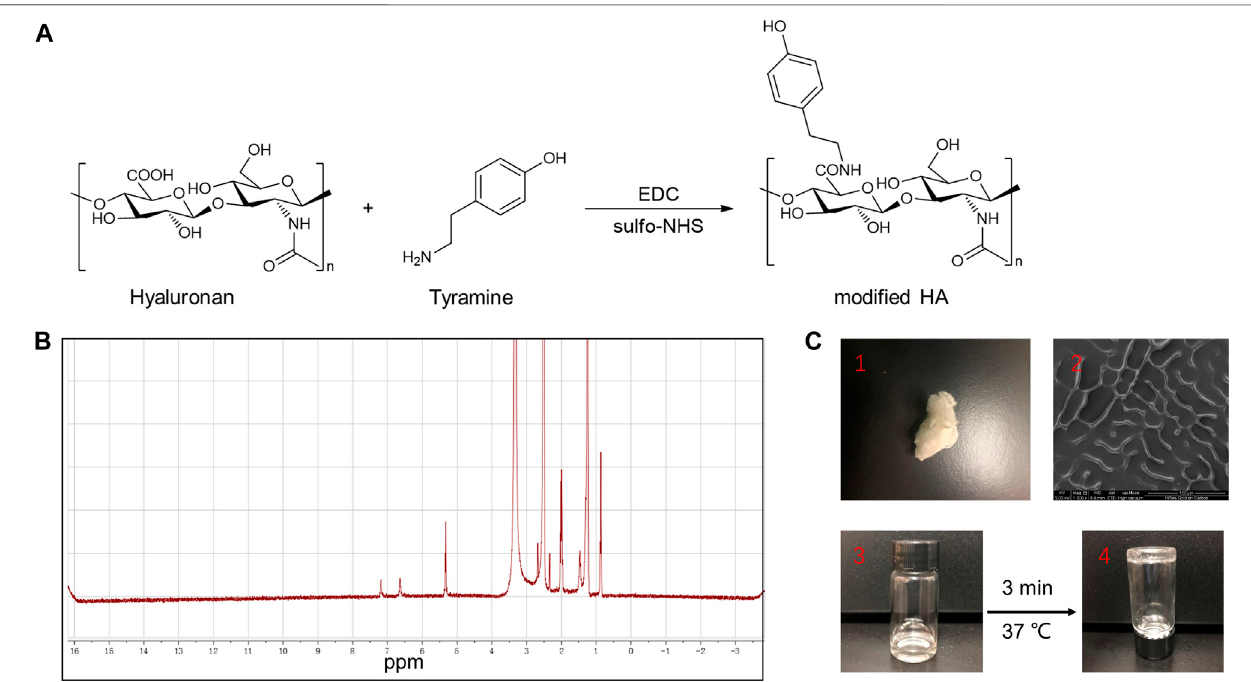
FIGURE3|(A) Synthesis ofTA-HA. (B) 1HNMRspectra ofmodi fi ed HA.( C -1) Themorphologyofthefreeze-dried TA-HA, waswhite fl occulent.( C -2) SEMimage ofTA-HA.( C -3)Themorphologyoffreeze-driedTA-HAinPBSsolutionwastransparent,colorless,and fl uid.( C -4)UnderthecatalysisofHRPandH2O2,TA-HAformed hydrogels after 3 minutes, and the morphology of hydrogels had a transparent and non- fl uid semi-solid nature.